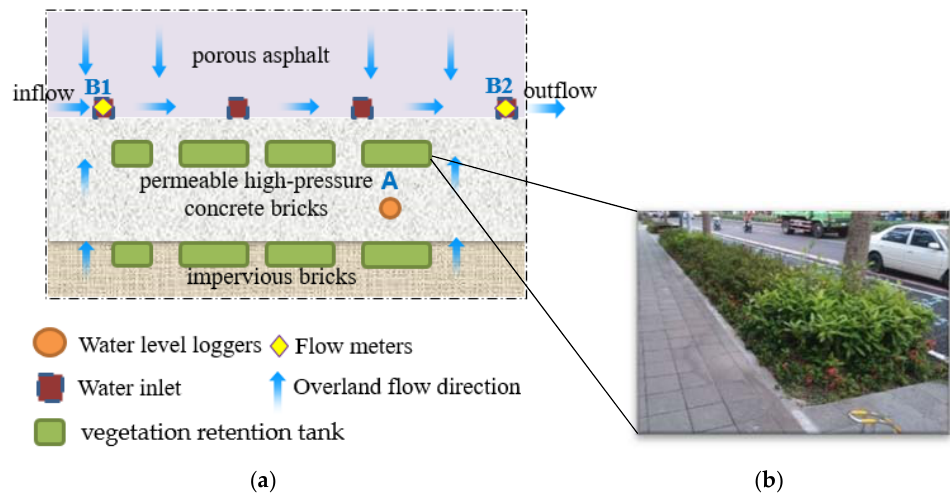
Figure 2. Location of the study site in Taipei city. The left-hand image shows the location of the city, and that on the right shows the study area.